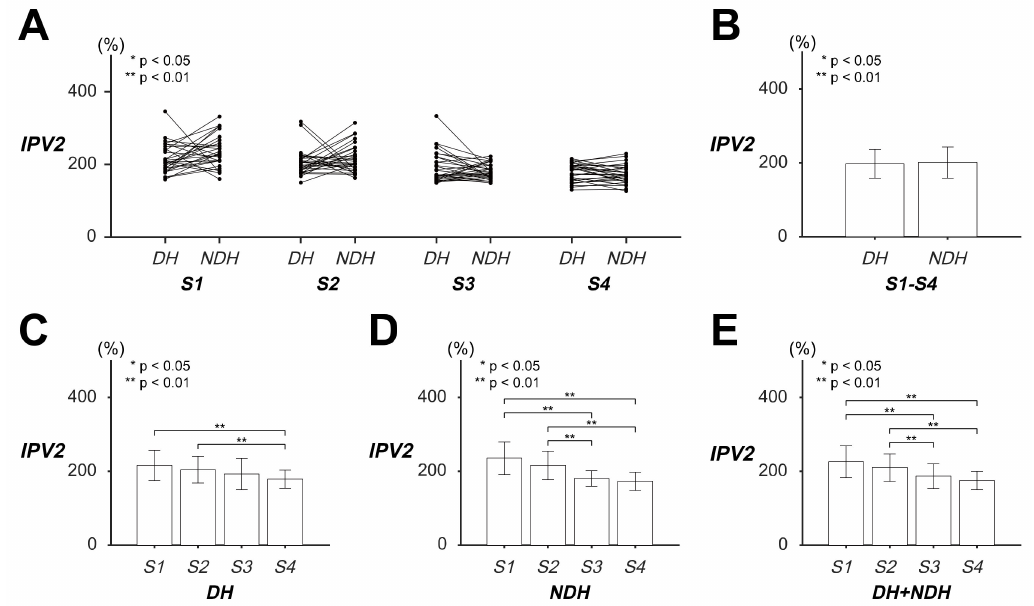
Table S1). The combined IPV2 suggested that the maximum speed di ff erences between the target and the tracer were approximately 39.25% and 23.63% larger at S1 and S2 than at S3 as well as 50.25% and